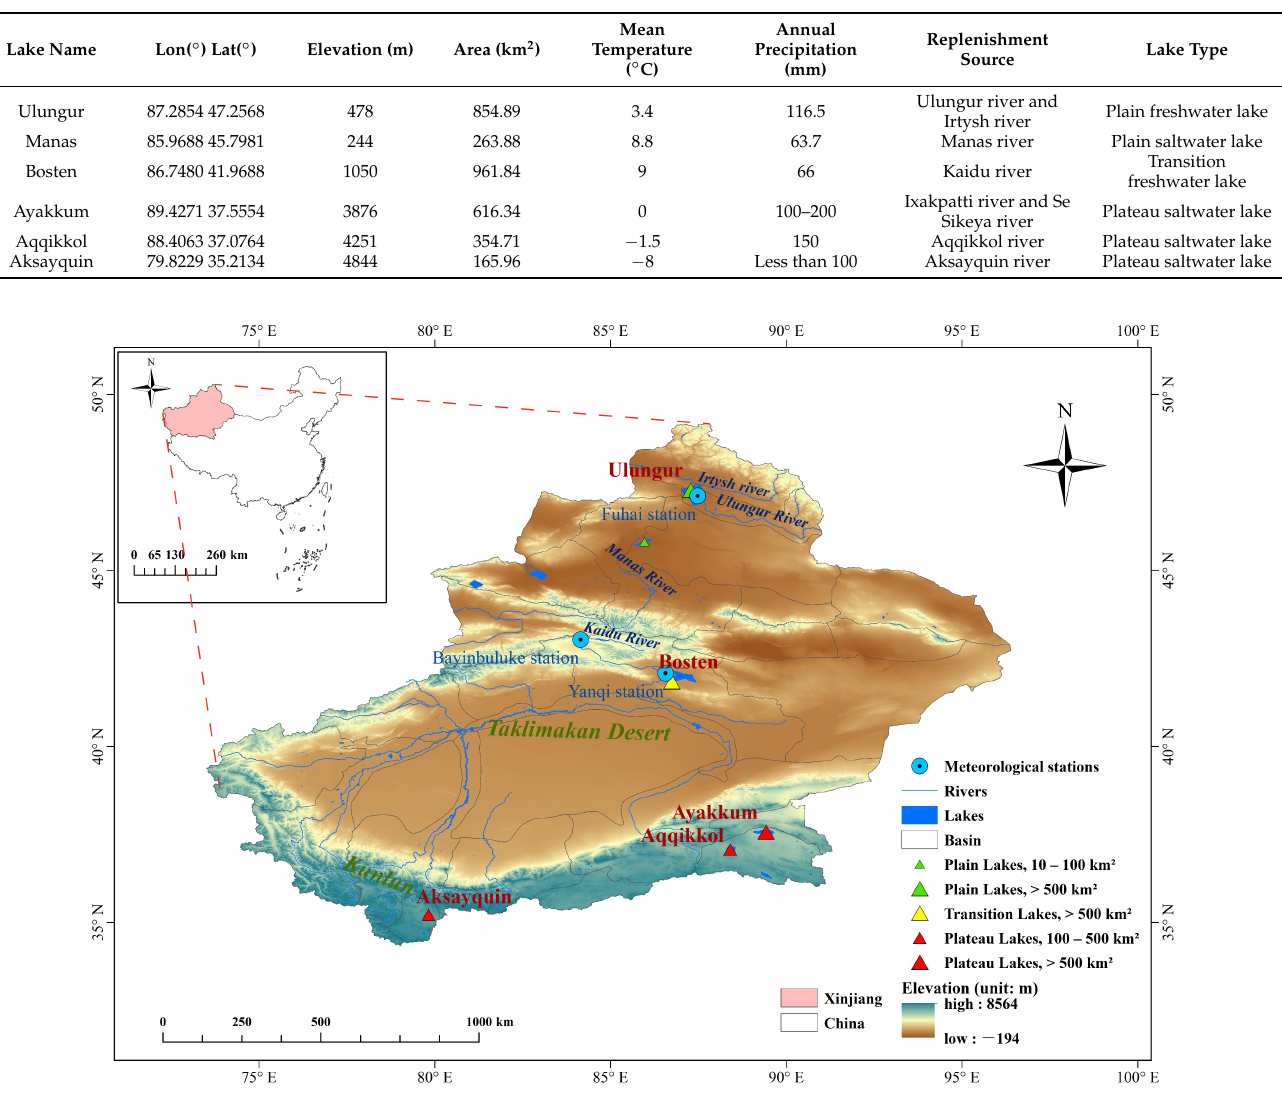
Figure 1. Distribution of six typical lakes in Xinjiang NO.: